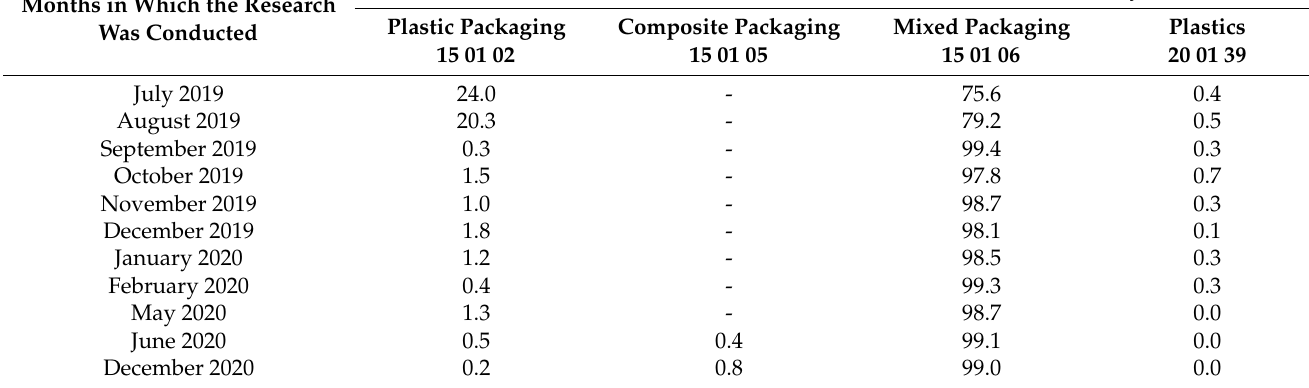
Table 1. The share of individual fractions of waste collected and selectively delivered to the analysed treatment plant (based on data from the plant).